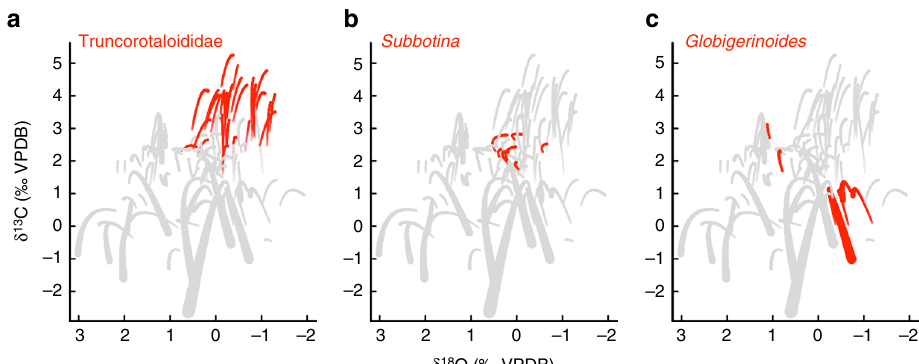
Fig. 4 Synthetic predictions of δ 18 O and δ 13 C size trends for key clades. All species shown in grey as in Fig. 3, but here with common mixed layer, photosymbiont-bearing groups from the Paleogene ( a ) and Neogene ( c ), and asymbiotic thermocline dweller Subbotina ( b ) picked out in red to highlight ‘ clumping ’ of closely related taxa in isotopic space